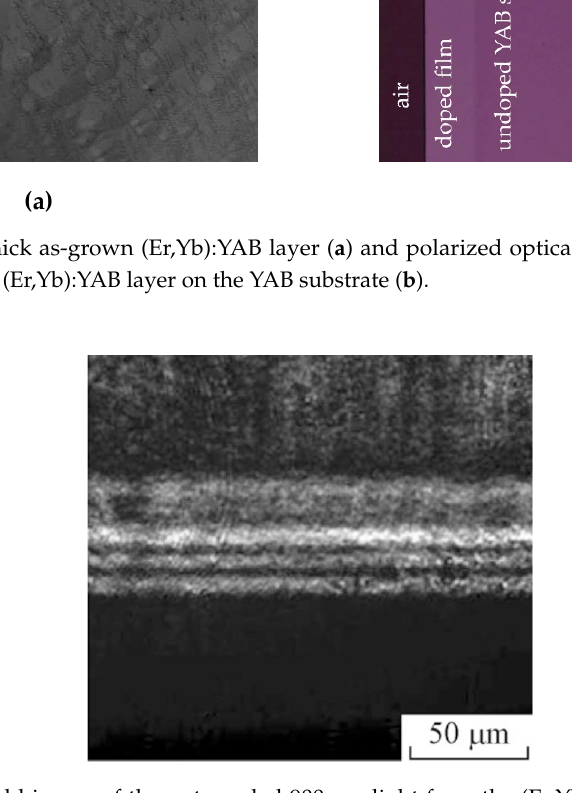
Figure 10. Near-field image of the outcoupled 900 nm light from the (Er,Yb):YAB waveguide [44]. Reprinted from Optical Materials, 32, Tolstik N., Heinrich S., Kahn A., Volkova E., Maltsev V., Kuleshov N., Huber G., Leonyuk N. High-temperature growth and spectroscopic characterization of Er,Yb:YAl 3 (BO 3 ) 4 epitaxial thin films, 1377–1379, Copyright (2010), with permission from Elsevier.